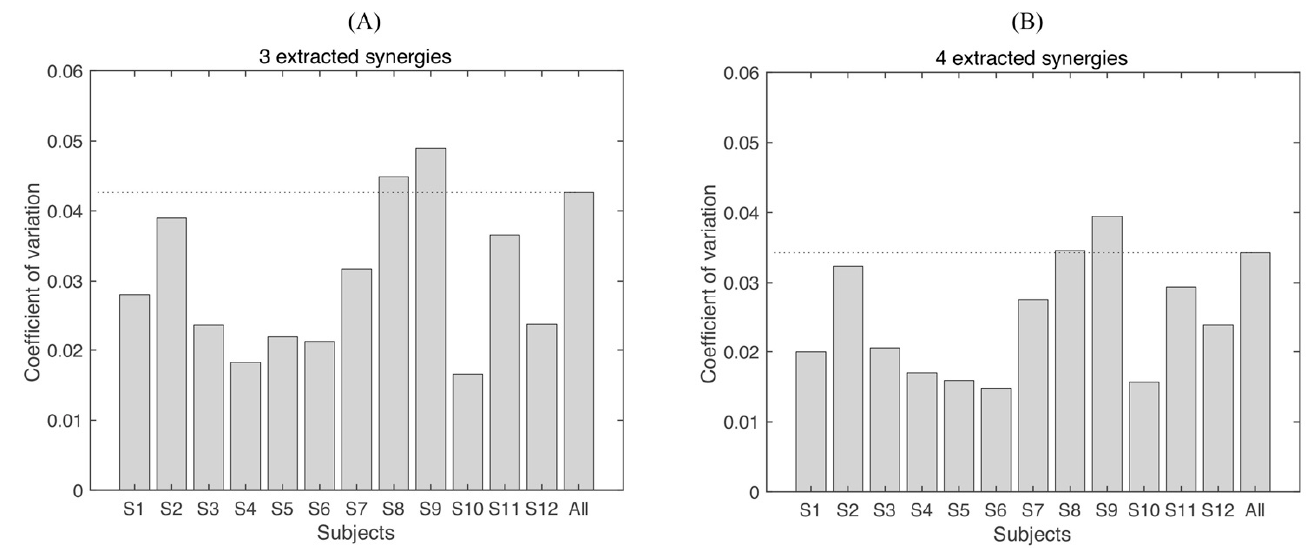
Figure 6. Coefficient of variation (CV) of the VAF. ( A ) Three synergies are extracted (imposing three synergies with NMF), and ( B ) four synergies are extracted (imposing four synergies with NMF). “All” indicates that the CV is calculated from all subjects and all repetitions, which includes the variability of intra-subject and inter-subject. The dashed line is the level at “All”.